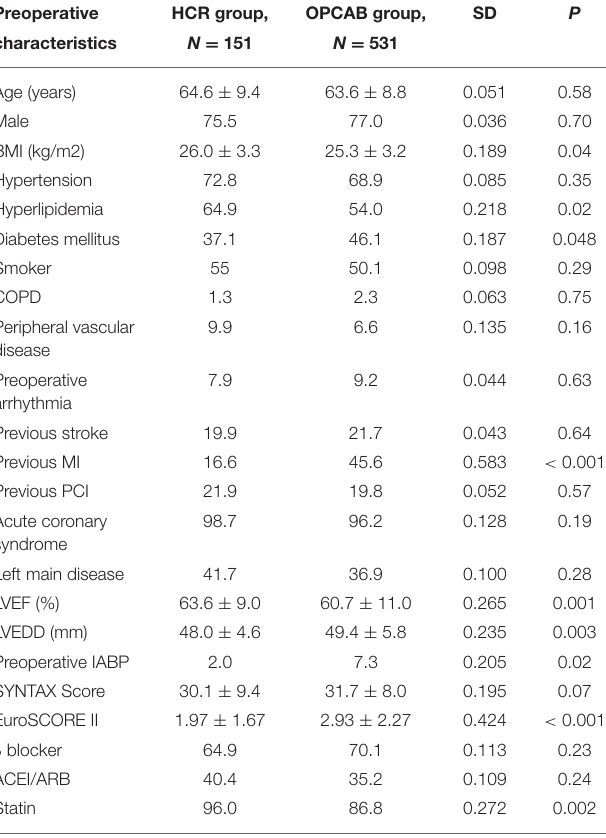
were not observed for the HCR and CABG groups ( Table 5